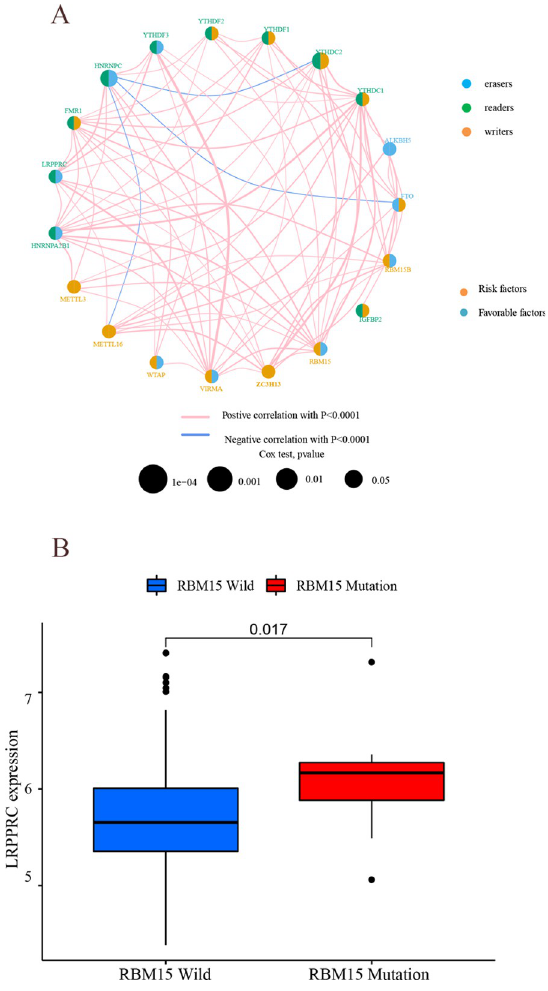
Fig 3. Analysis of m 6 A regulators. (A) m 6 Aprognostic network diagram. In the circle corresponding to each m 6 A modified gene, the yellow part of the left half-circle indicates risk genes, the blue part indicates protection genes, the blue part of the right half-circle indicates demethylase, the green part indicates methylated reading protein, the yellow part indicates methyltransferase, the pink linkage between genes indicates synergism, and the blue linkage indicates repression. (B) Mutation and expression correlation analysis. The horizontal coordinates indicate the RBM15 wild group and mutant group, respectively, while the vertical coordinates indicate the LRPPPC